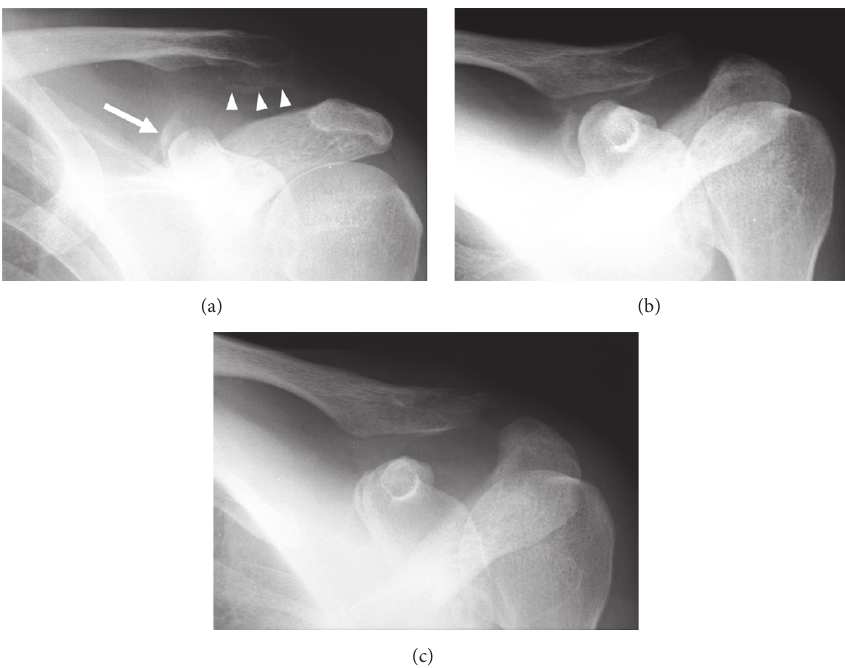
Figure 2: Imaging of Case 2. (a) Radiogram taken at the first visit showing the acromioclavicular dislocation and avulsion fracture of the superomedial side of the coracoid process (arrow) and the inferior side of the clavicle (arrow heads). (b) Angle up view taken at the first visit showing avulsion fracture of the coracoid located on the posteromedial side of the coracoid angle (compatible with the attaching site of the conoid ligament). (c) Radiogram taken 1 year and 6 months after the injury demonstrating firm union of the avulsed coracoid